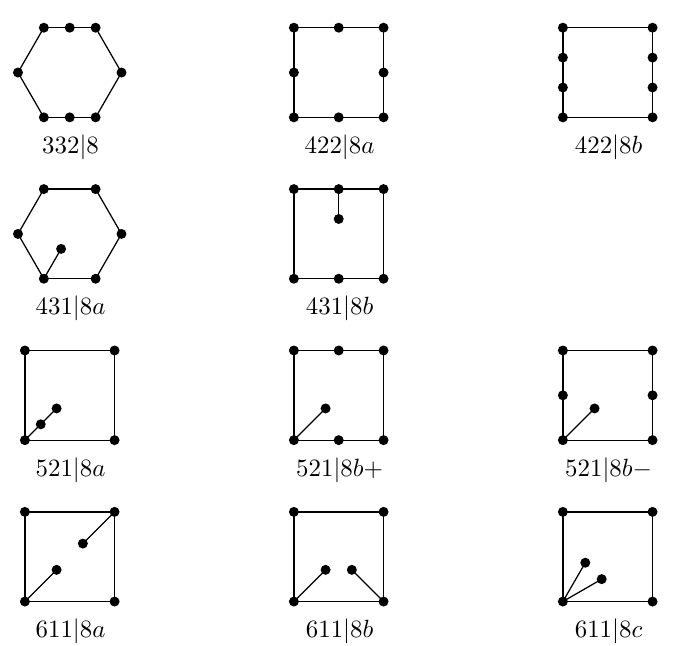
Figure 1. Unicellular dessins of genus 1 with 4